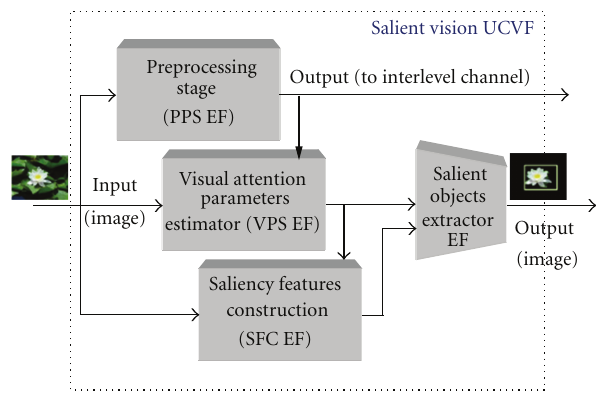
Figure 4: Bloc-diagram of Salient Vision UCVF, handling the automated detection of salient